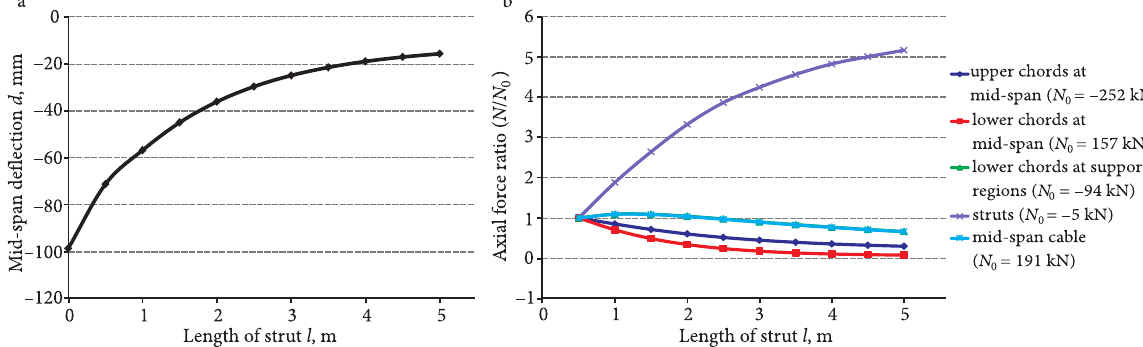
Fig. 5. Variation of mid-span deflection and axial force ratio with the length of strut: a – mid-span deflection versus the length of strut; b – axial force ratio versus the length of